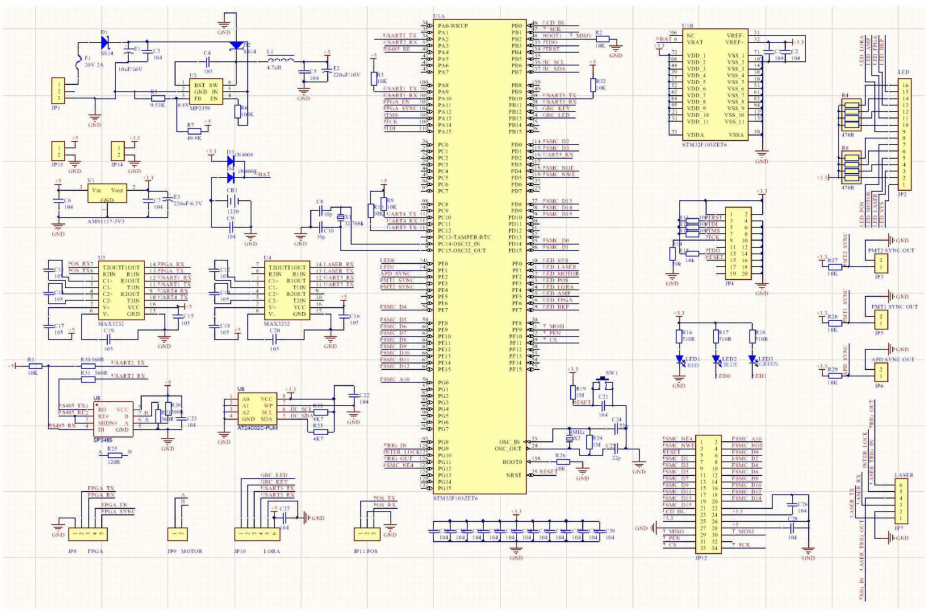
Figure 10. Circuit scheme of the main control section.